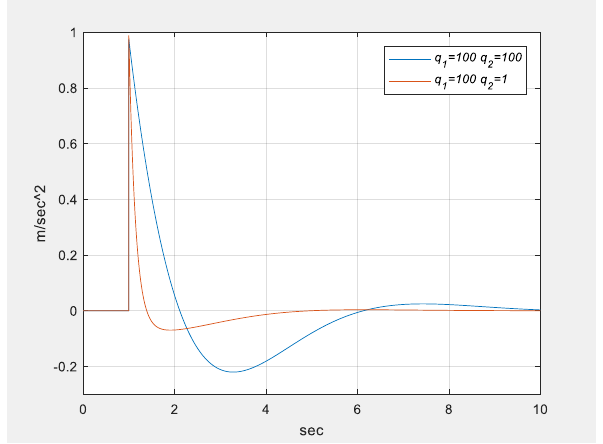
.  and the θ s and the  and the s  and the s s